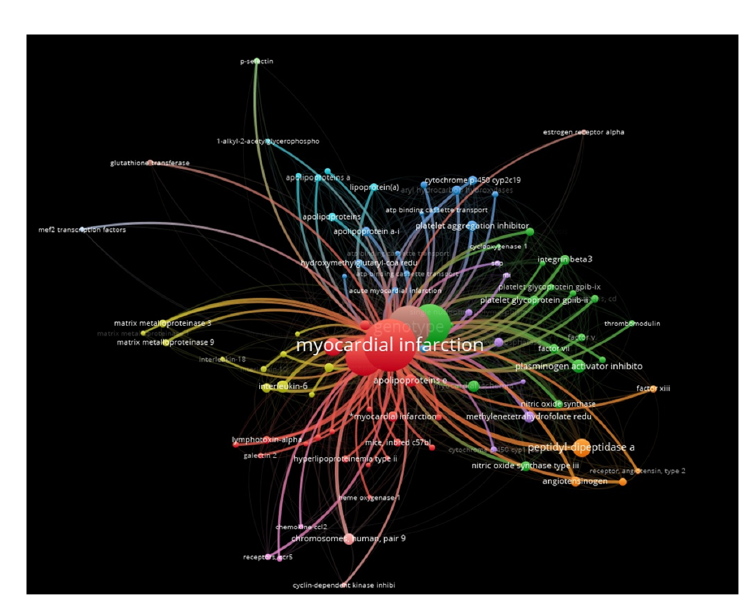
Figure A1. PubMed map and network.